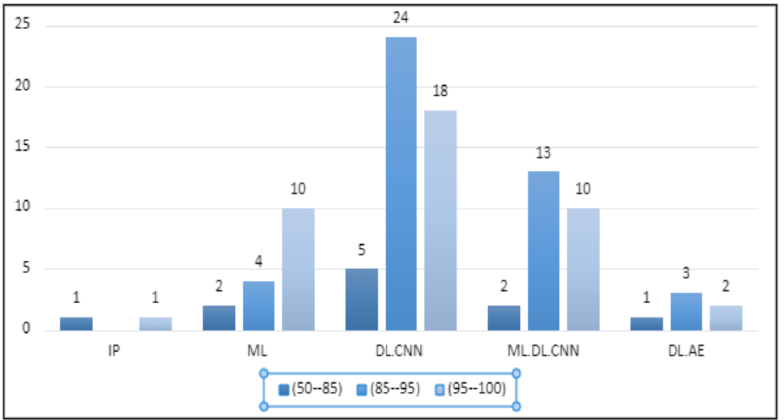
Figure 13. Observed performance evaluation with respect to our defined thematic classification